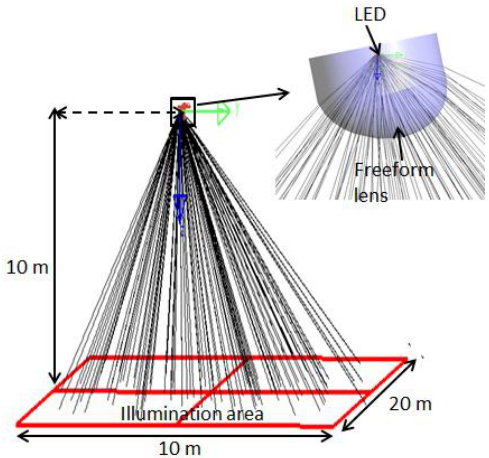
Figure 17. The structure of an LED street light based on freeform optics design and its raytracing analysis.